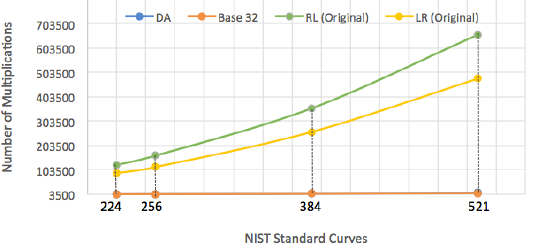
Figure 4. Our work vs. Original algorithms in Terms of Number of Multiplications: blue and red lines are superposed.